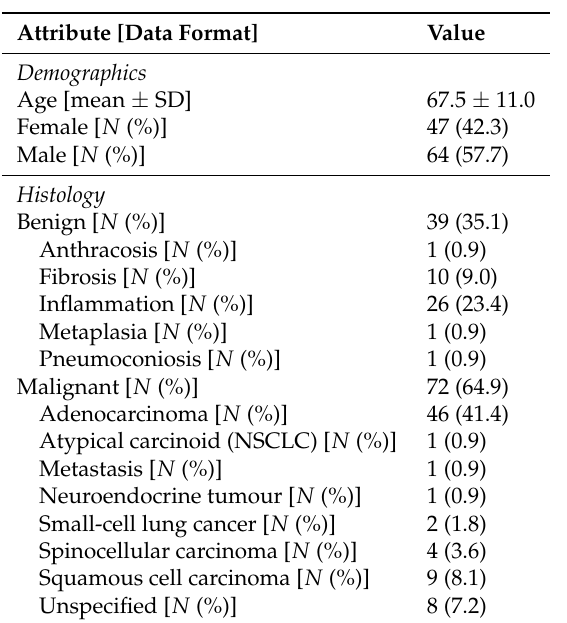
Table 1. Characteristics of the patient